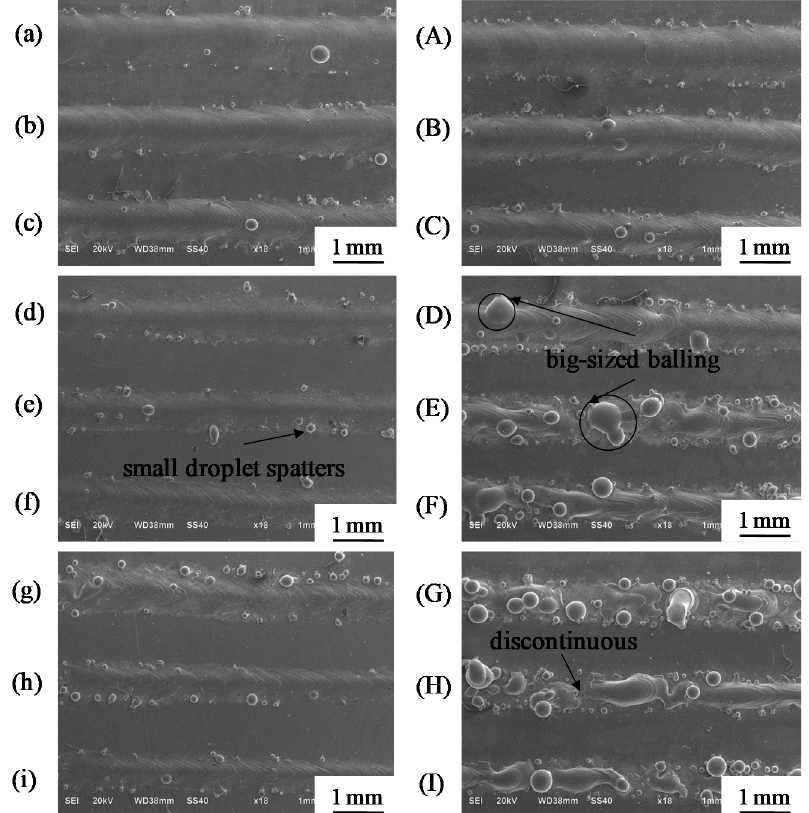
Figure 4. SEM micrographs showing the surface of single-scan tracks produced with different laser beam diameters (the beam diameter Φ D is 50 µm in the left column and Φ D is 200 µm in the right column). ( a , A ) v = 25 mm/s; ( b , B ) v = 50 mm/s; ( c , C ) v = 75 mm/s; ( d , D ) v = 100 mm/s; ( e , E ) v = 125 mm/s; ( f , F ) v = 150 mm/s; ( g , G ) v = 175 mm/s; ( h , H ) v = 200 mm/s; ( i , I ) v = 225 mm/s.